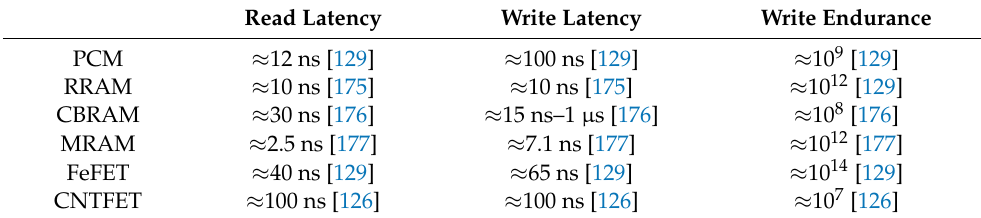
Figure 6. Nonvolatile memories attributes, assets and application potentials. Table 1. Read latency, write latency, and write endurance of different